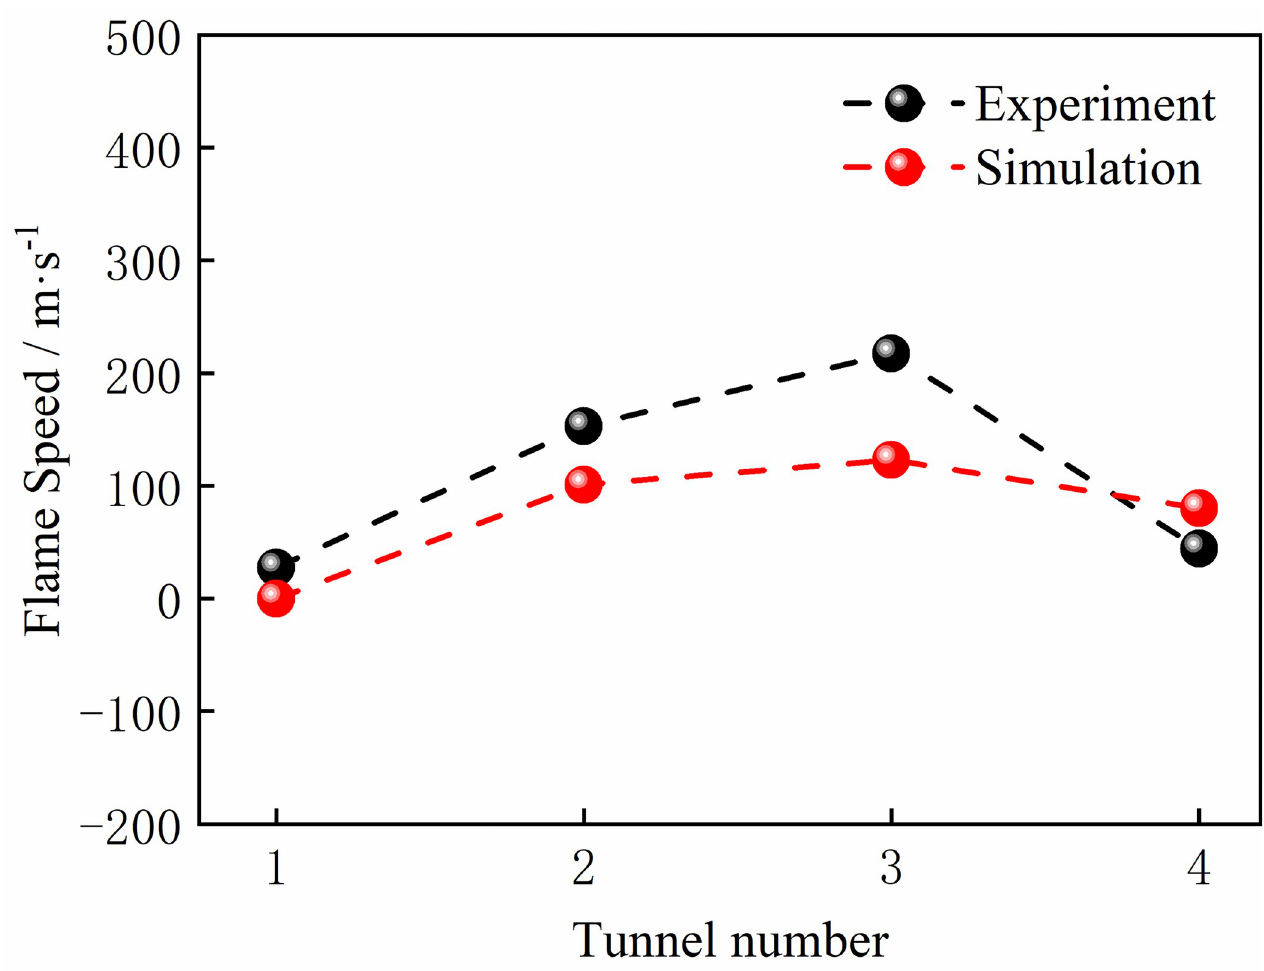
Fig 6. Experimental and simulant flame comparison at a concentration of